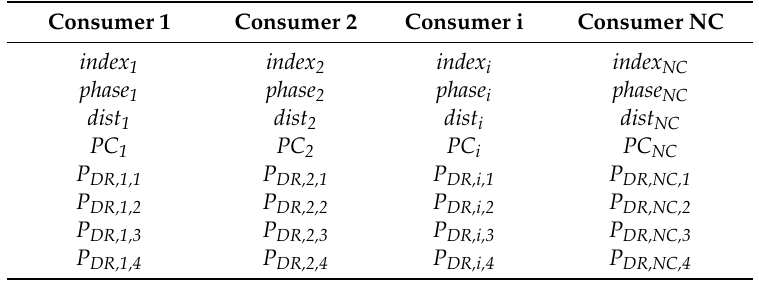
Table 2. The input data required by the algorithm—the structure of matrix